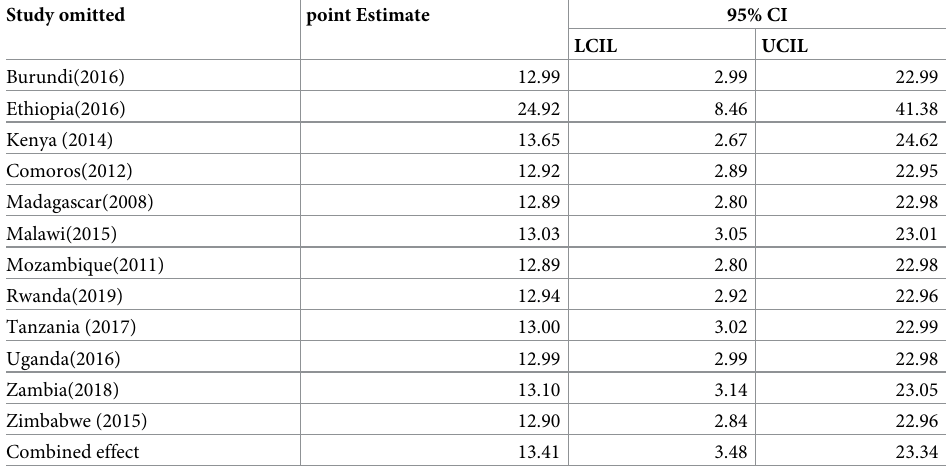
Table 3. Sensitivity analysis of the pooled prevalence of diarrheal diseases among pregnant women in East